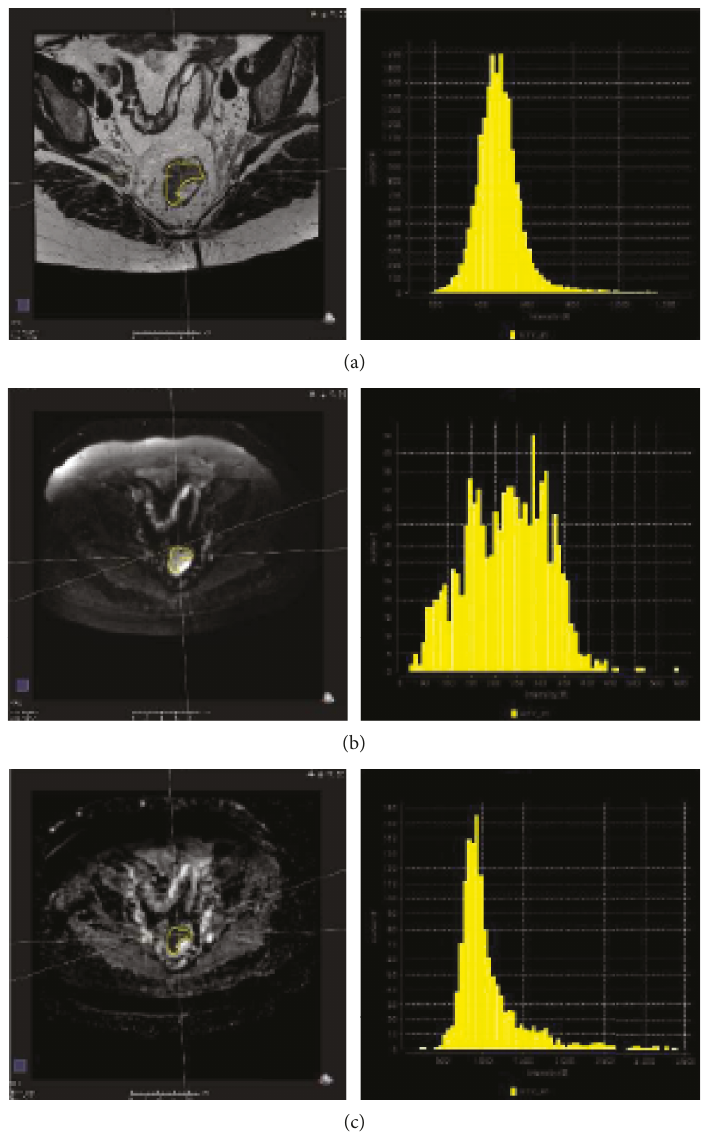
Figure 1: The gross tumor volume (GTV) was evaluated at baseline by MRI and contoured on T2 (a), DWI (b), and ADC (c)